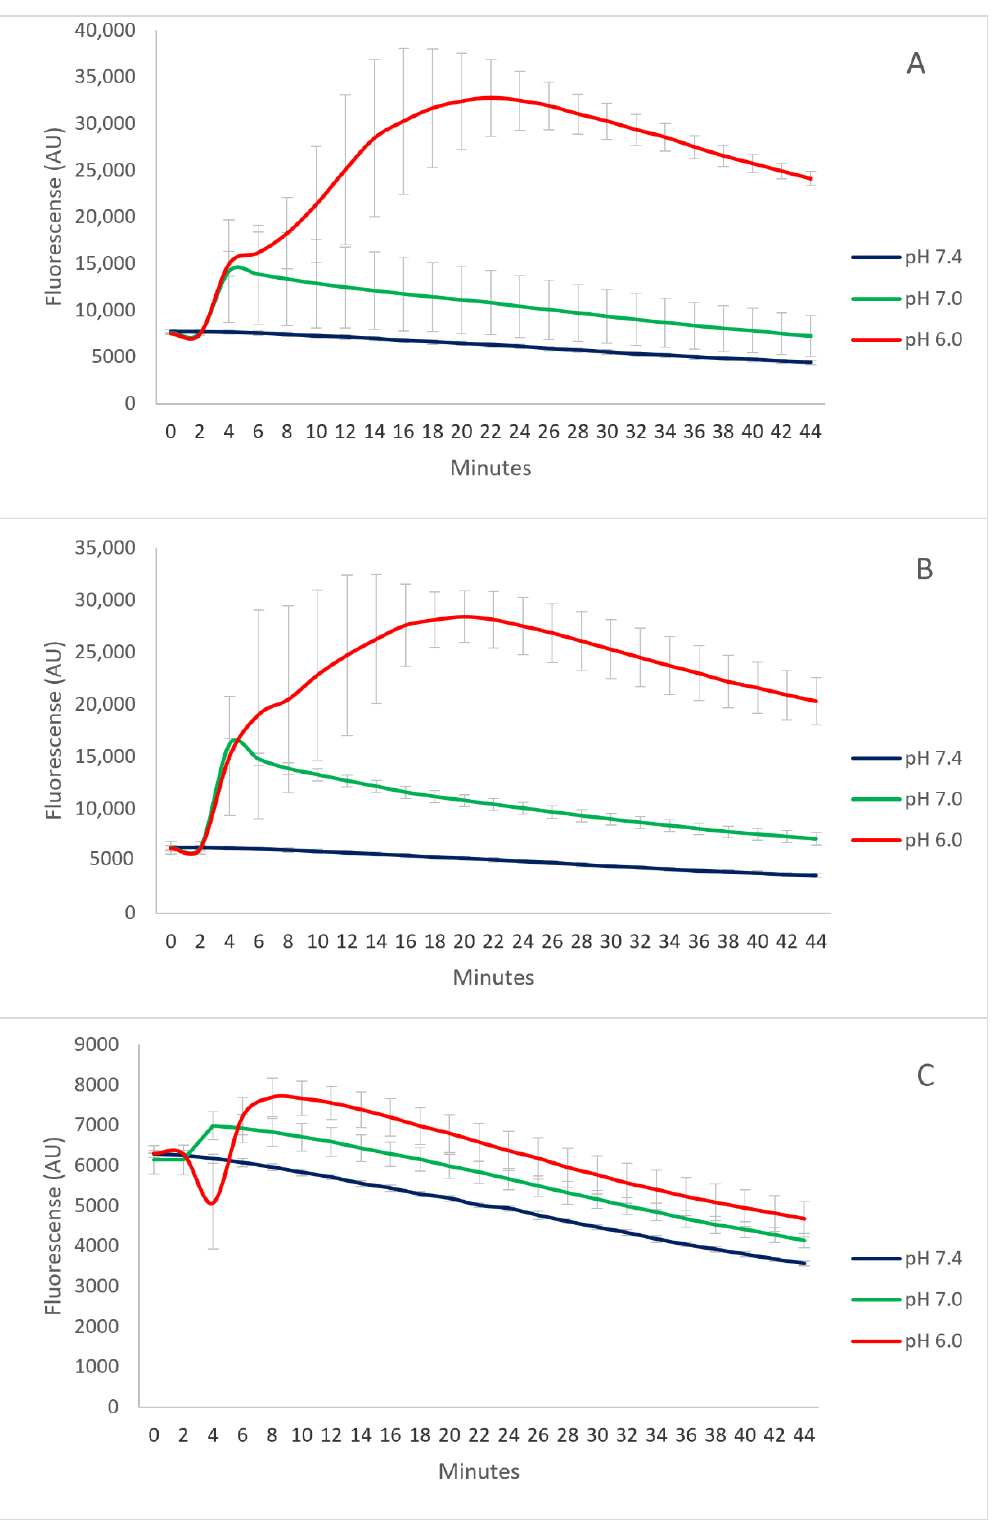
Figure 1. The pH-dependent calcein release from pH-Lip, pH-Lip–PEG750 and pH-Lip–PEG2000 after the addition of HCl to a 7.4 PBS buffer medium. Data represent the mean ± standard deviation (n = 3). ( A ): pH-Lip ( B ): pH-Lip–PEG750 and ( C ): pH-Lip–PEG2000.